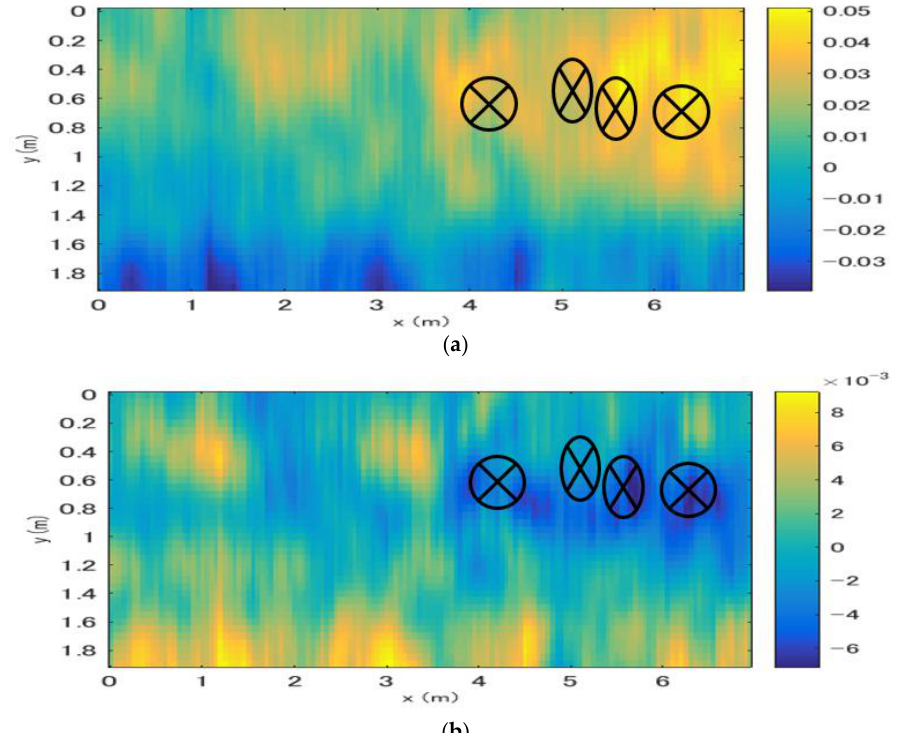
Figure 13. Deviations in the velocity and thickness estimated at the Sendai Airport survey area, the location of damaged parts are also plotted on the results ( a ) Velocity deviations. ( b ) Thickness deviations.